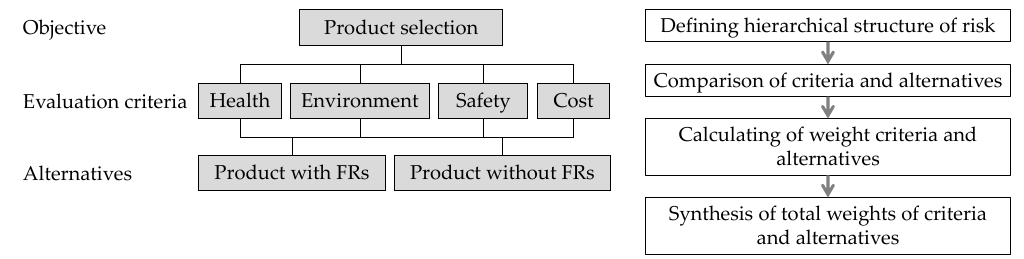
Figure 2. Hierarchical structure of AHP for product selection ( left ) and process flow to determine weightings using AHP ( right ).